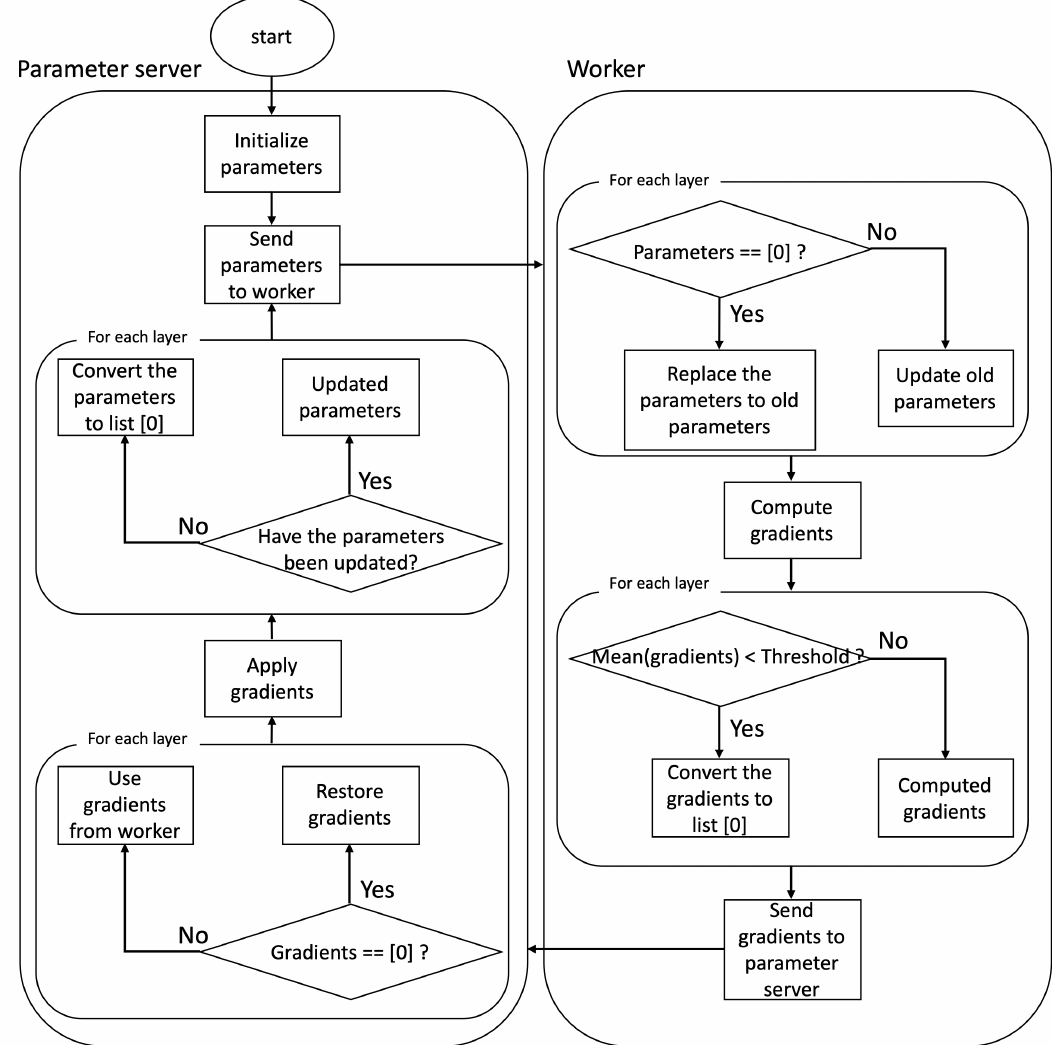
Figure 4. Flowchart of the operation of the parameter server and